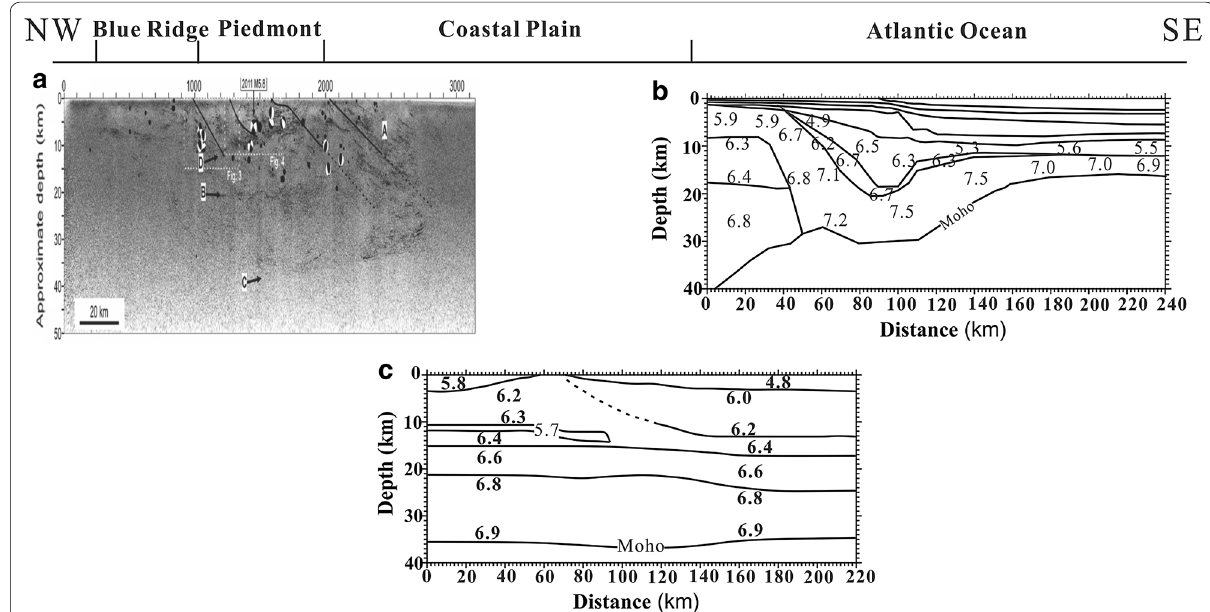
Fig. 14 Comparison of models of a Pratt et al. (2014), b Holbrook et al. (1994), and c our study. The locations of a, b, and c are, respectively, shown as line A–A ′ , line E–E ′ , and line 1 in Fig. 1. These three profiles have nearly the same azimuth and model a , b are nearly collinear. Model c is located about 70 km to the south. The three Figures are at the same scale. Note that Fig. 14a is taken from Fig. 2 in Pratt et al. (2014) and that labels “A” to “D” and solid/dashed black lines of Fig. 14a are not used for our study